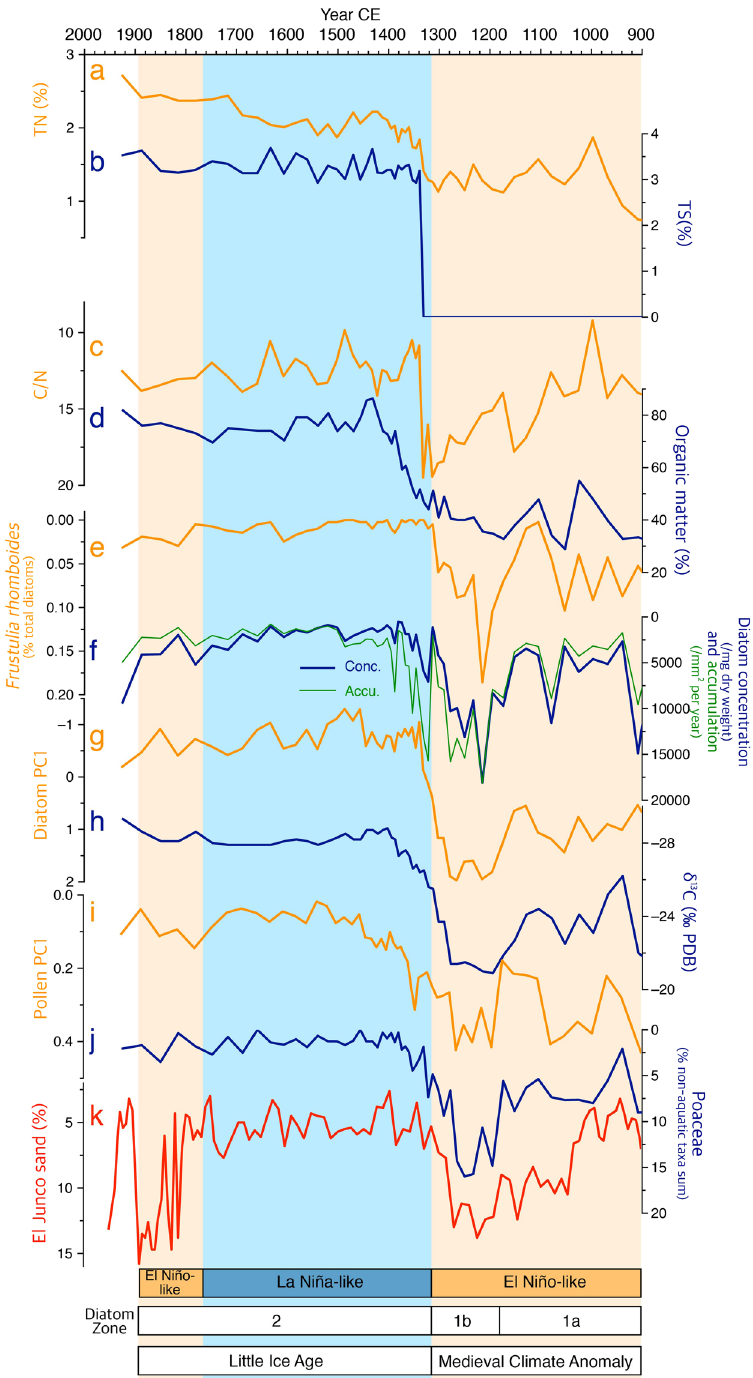
Figure 3. Comparison between Mulyoungari paleoenvironmental proxy data ( a–j ) and sand percentage records from El Junco Lake, Galapagos ( k ) 52 . ( a ) TN (%). ( b ) TS (%). ( c ) C/N ratios. ( d ) Organic matter (%). ( e ) Frustulia rhomboides (% total diatom). ( f ) Diatom concentration (blue) and accumulation (green). ( g ) Diatom PC1. ( h ) Stable carbon isotope ratios. ( i ) Pollen PC1. ( j ) Poaceae (% non-aquatic pollen and spore sum). ( k ) El Junko Sand %. Dry periods are indicated by orange boxes while wet periods by blue